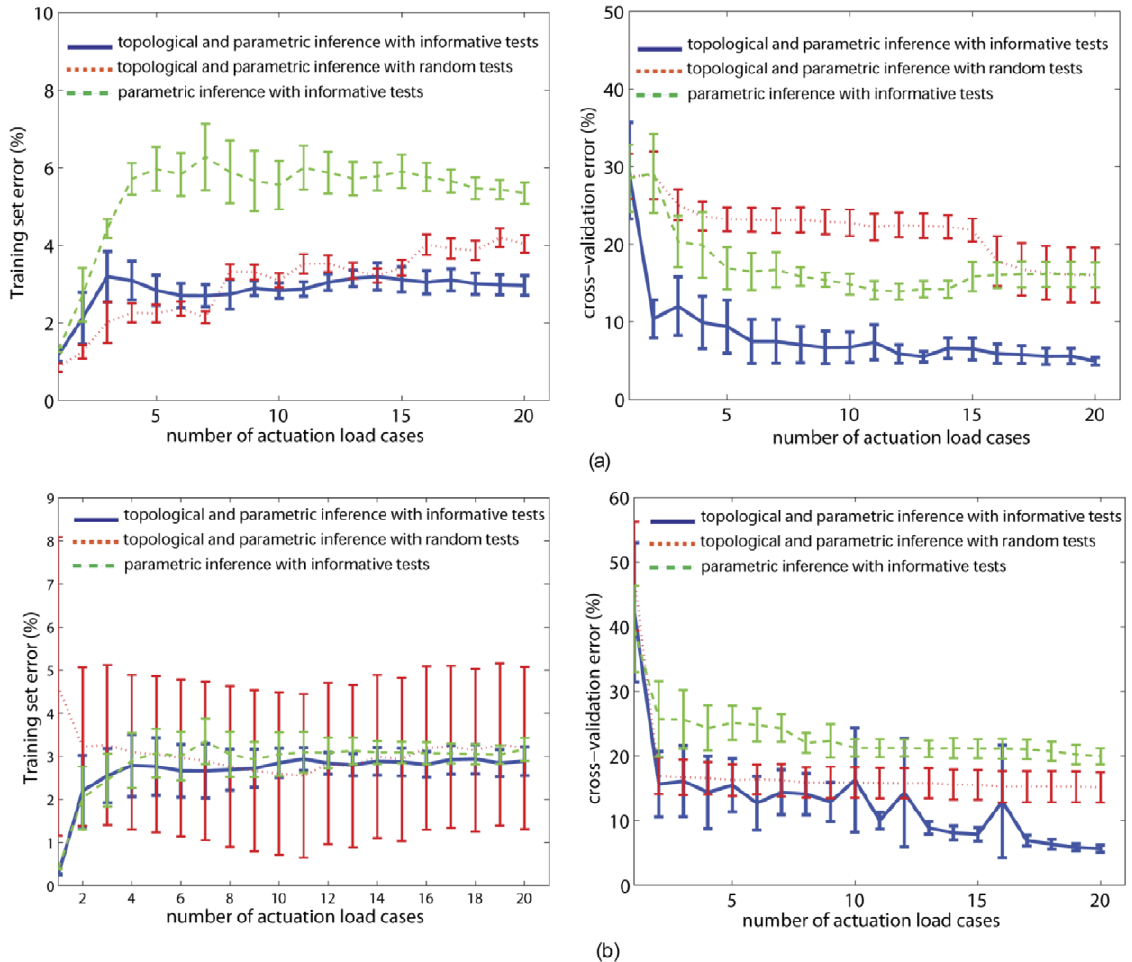
Figure 5. Topology matters and so does informative data generated from the inference process. Training set (left column) and cross validation (right column) errors when (a) the ‘AFH’ target is inferred and (b) when the ‘aWR’ network is inferred. Solid lines represent errors with sequential informative experimental data when both topologic and parametric inference is performed. Dotted lines correspond to cases when random experimental data is sequentially employed for inference. Dashed lines show errors for only parametric inference with basic (Fig. S2 c–d) topologies. Error bars represent standard errors across three executions of the inference processes. Topologically and parametrically inferred networks with sequentially introduced informative force-motion data are more functionally proximal to the respective targets compared to (i) when random data is used and (ii) when module/string interconnectivity is ignored during inference.